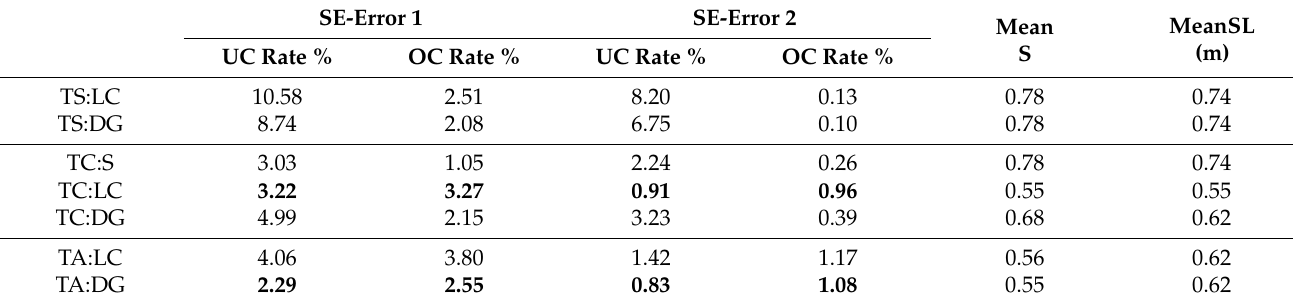
Figure 6. UC rate vs. OC rate curves as a function of the threshold S on the LSTM output. Table 1. Undercount (UC) and overcount (OC) rates for our step counter, along with the mean threshold S and stride length SL . For each community of blind walkers (LC, DG), the pair (UC rate, OC rate) with the smallest value of their sum is shown in